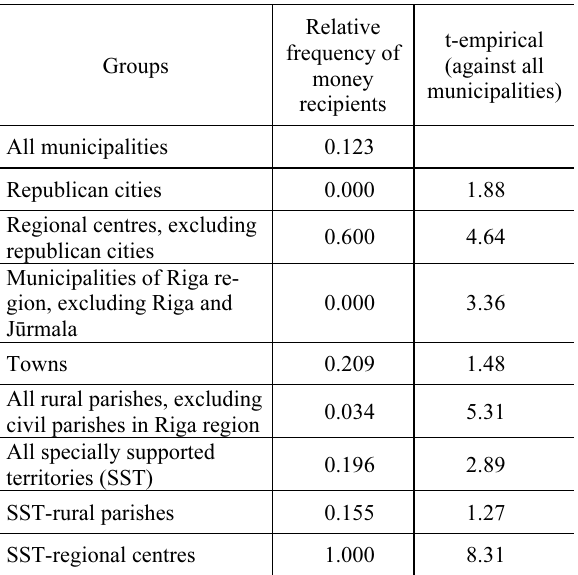
Table 7. Distribution of structural funds administered by LIDA to municipalities according to enterprise registration